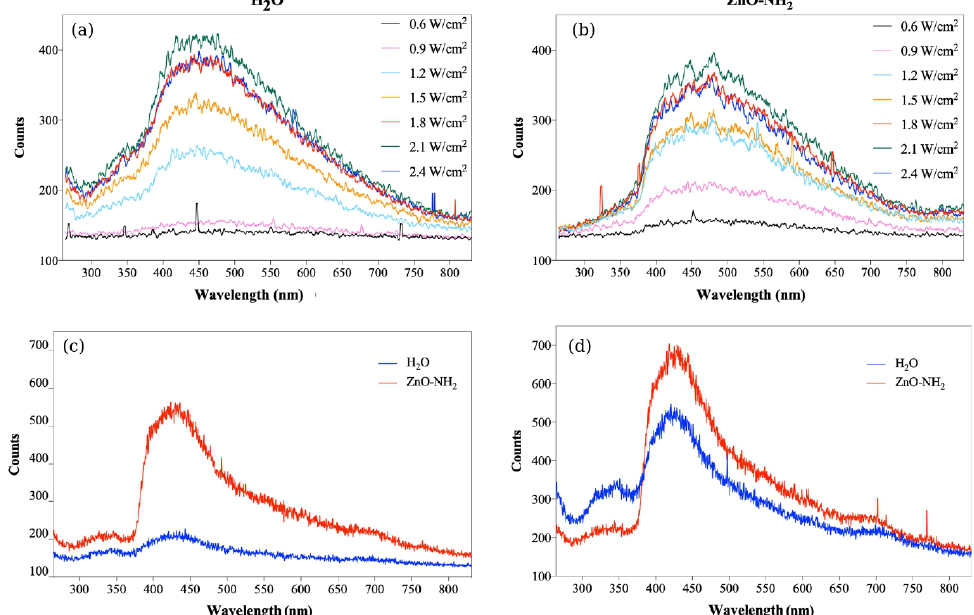
Figure 5. Sonoluminescence light spectra in ( a ) pure water and ( b ) in water containing ZnO-NH 2 nanoparticles for different levels of ultrasound intensity. ( c , d ) The same sonoluminescence light spectra as in ( a , b ), but measured in an argon-saturated environment at ultrasound intensities of 0.9W/cm 2 and 1.2W/cm 2 , respectively. One can see a significant increase in the number of counts (i.e., the number of photons received by the photodetector) in the presence of ZnO-NH 2 nanoparticles compared with data obtained using water. Reproduced from [58] under the terms of a Creative Commons